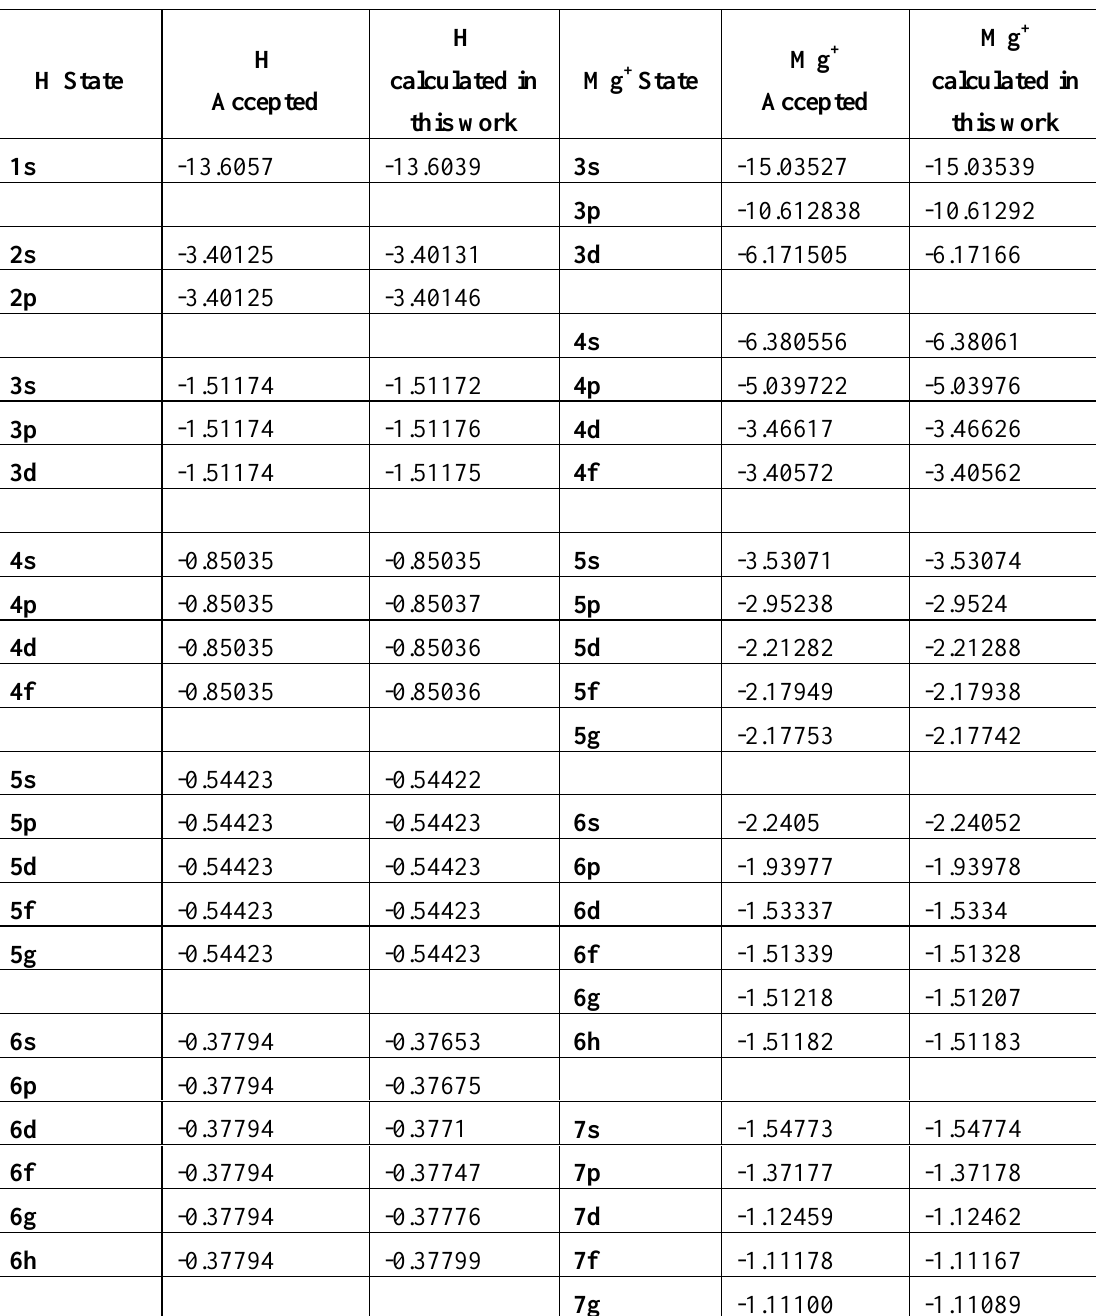
Table III. Accepted and our calculated values for selected energy levels of H [21] and Mg + [22]. Due to the computational algorithm the series calculated for the n ≥ 7 states are incomplete. All values are in eV and are calculated so the free electron has energy E =0. States do not correspond across